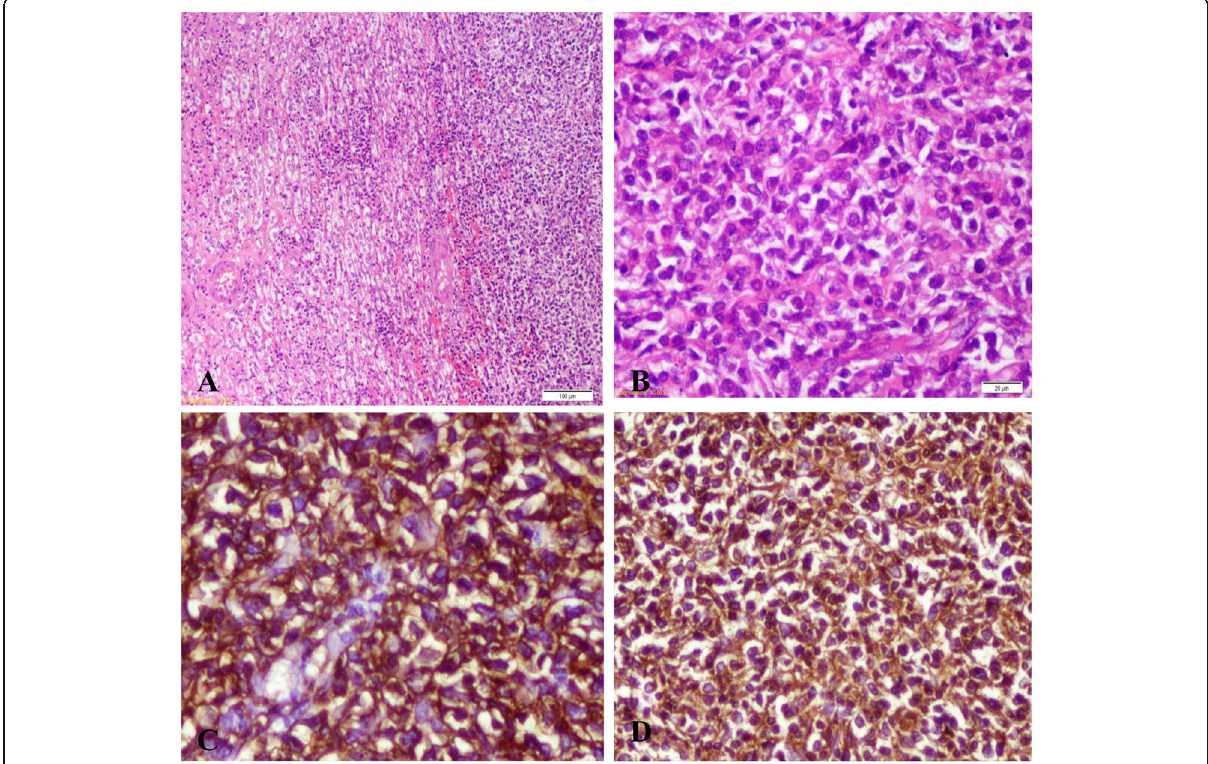
Fig. 4 a Primary adrenal lymphoma showing infiltration of the adrenal cortex by diffuse proliferation of large transformed B lymphocytes (Hematoxylin and eosin, × 100). b The cells showed enlarged nuclei, conspicuous nucleoli and scanty cytoplasm with scattered mitotic figures (Hematoxylin and eosin, × 400). c , d Diffuse membranous staining in transformed lymphocytes for CD20 and LCA, respectively (×